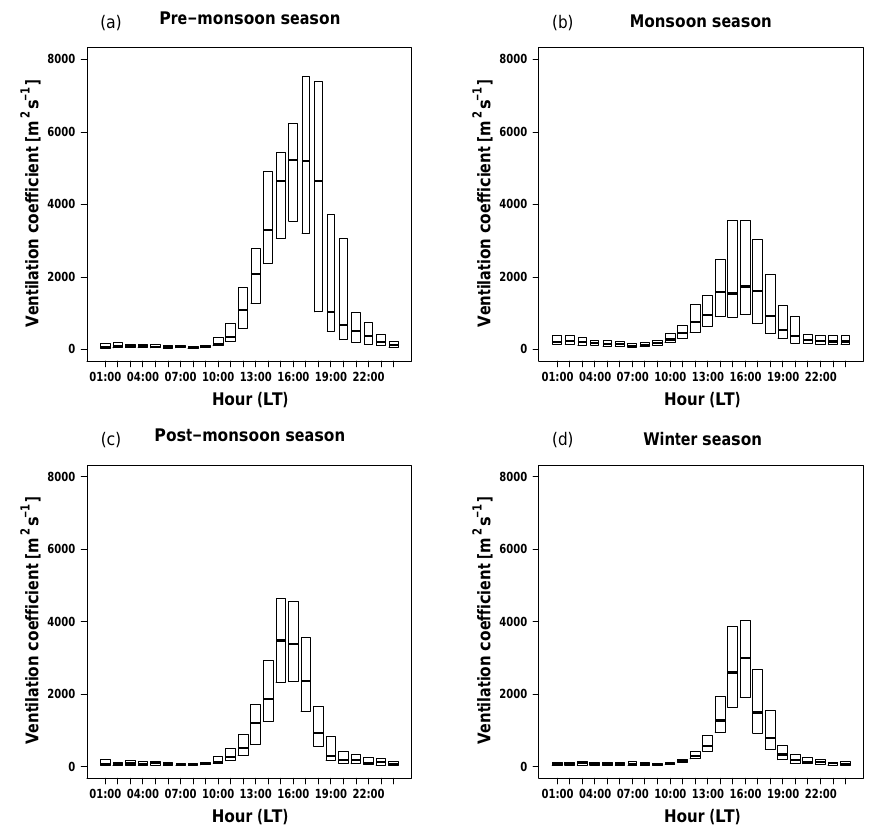
Figure 7. Diurnal cycle of the ventilation coefficient as a boxplot (showing the median, the upper and lower quantile) for the (a) pre- monsoon (March–May 2013), (b) the monsoon (June–September 2013), (c) the post-monsoon (October–November 2013) and (d) the winter (December 2013–February 2014) season at the Bode site.